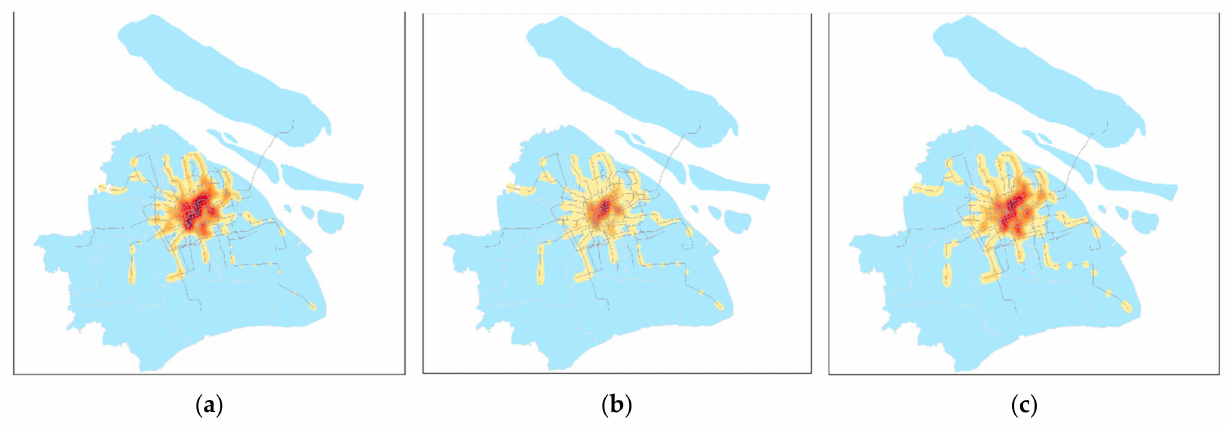
Figure 17. Heat maps of spatial factors and RMSE. The darker the color, the higher the value. ( a ) The count of import and export; ( b ) The number and type of POI; ( c ) The mean RMSE on